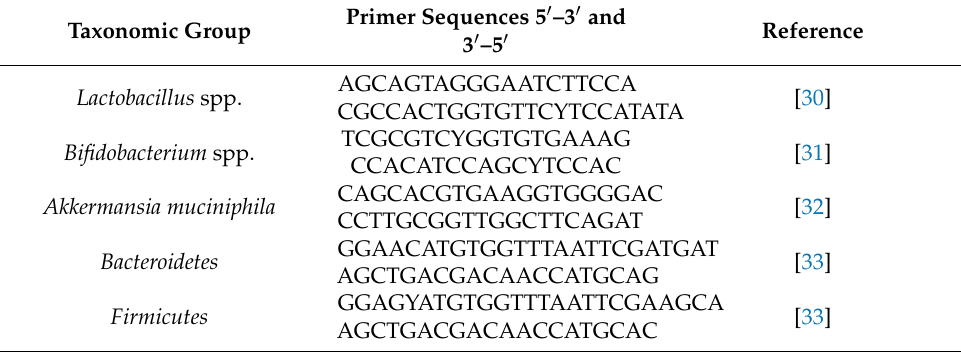
Table 1. Primers used for qPCR quantification of 5 specific taxonomic groups. Taxonomic